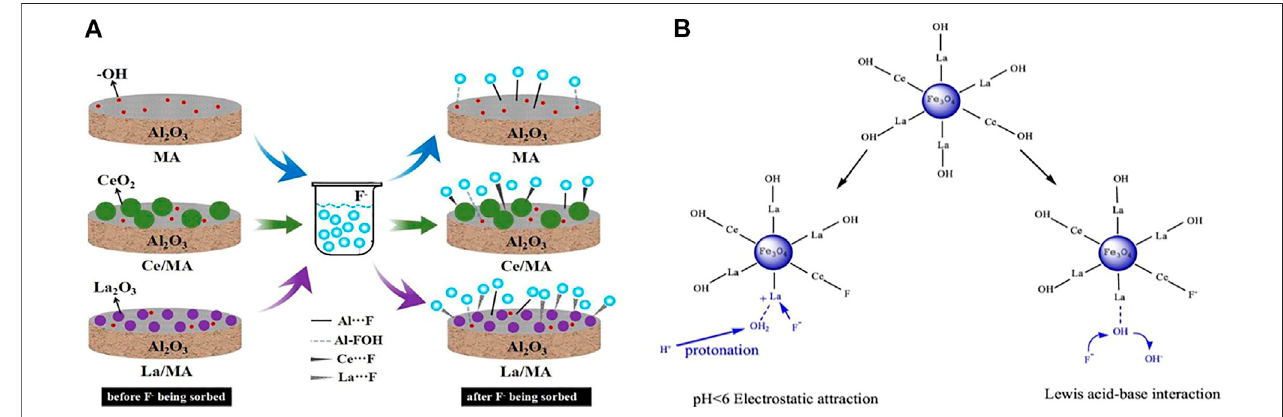
FIGURE 4 | Schematic principle of modi fi cation on Al 2 O 3 (A) (He et al., 2019) and Fe 3 O 4 (B) (Han et al., 2019) by La, Ce, and fl uoride adsorption mechanism.